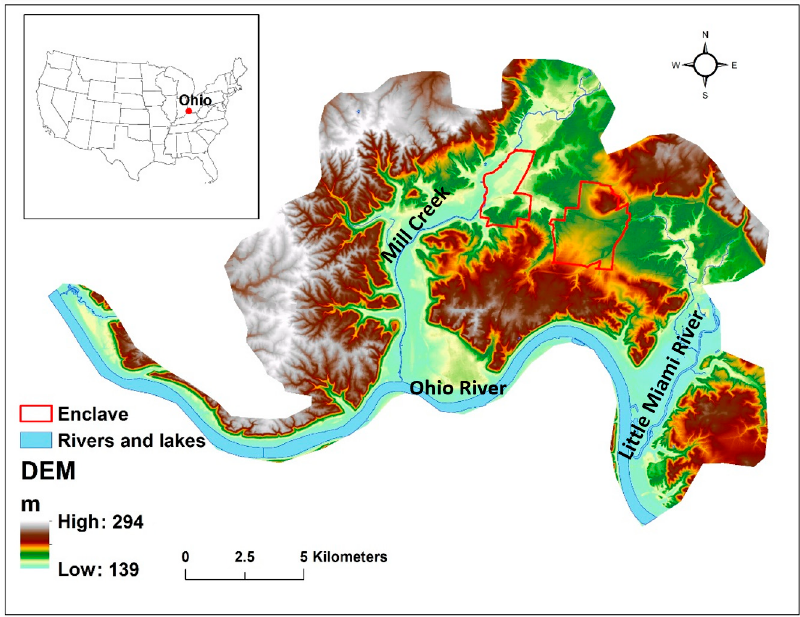
Figure 1. Location map of the study area.